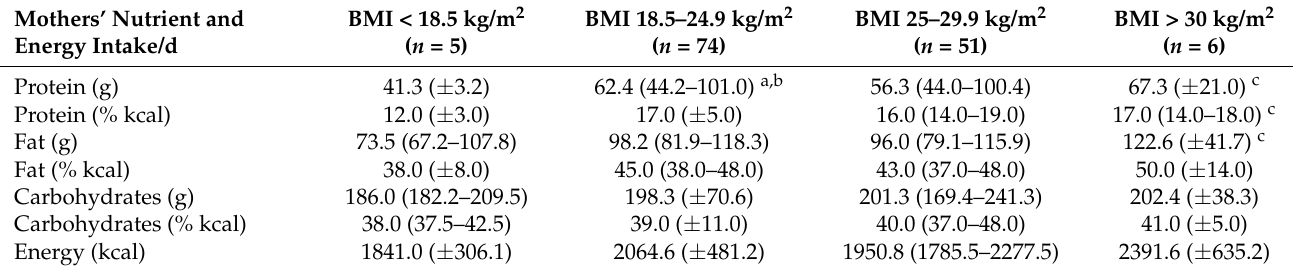
Table 5. Maternal nutritional intake related to different maternal BMI